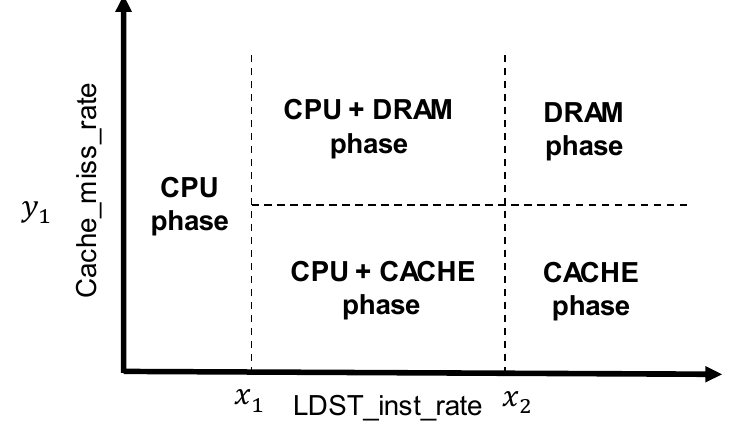
Figure 5. Visualization of CPU phase classification.